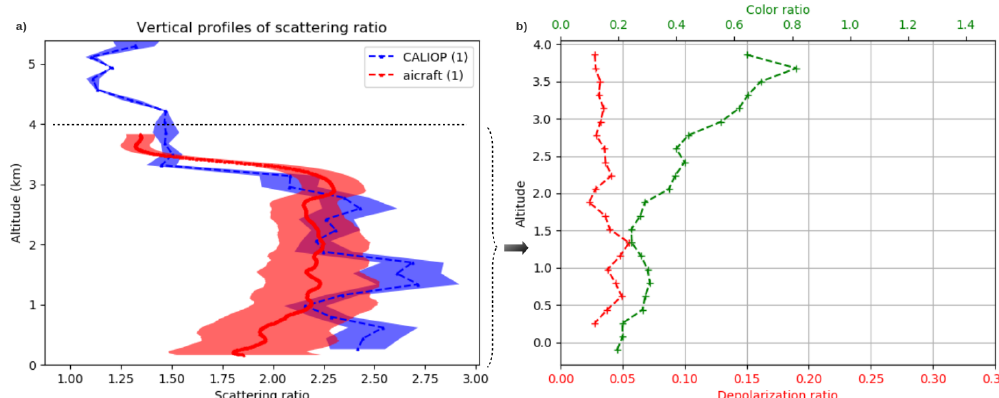
Figure 10. ( a ) Vertical profiles of 532 nm backscatter ratio for the aircraft lidar in red box of Figure 7a (red line) and for CALIOP on 18 June 2017 at 21 UT and 57 ◦ N (blue line). ( b ) Vertical profiles of the particle color ratio (green) and particle linear depolarization ratio (red) measured by